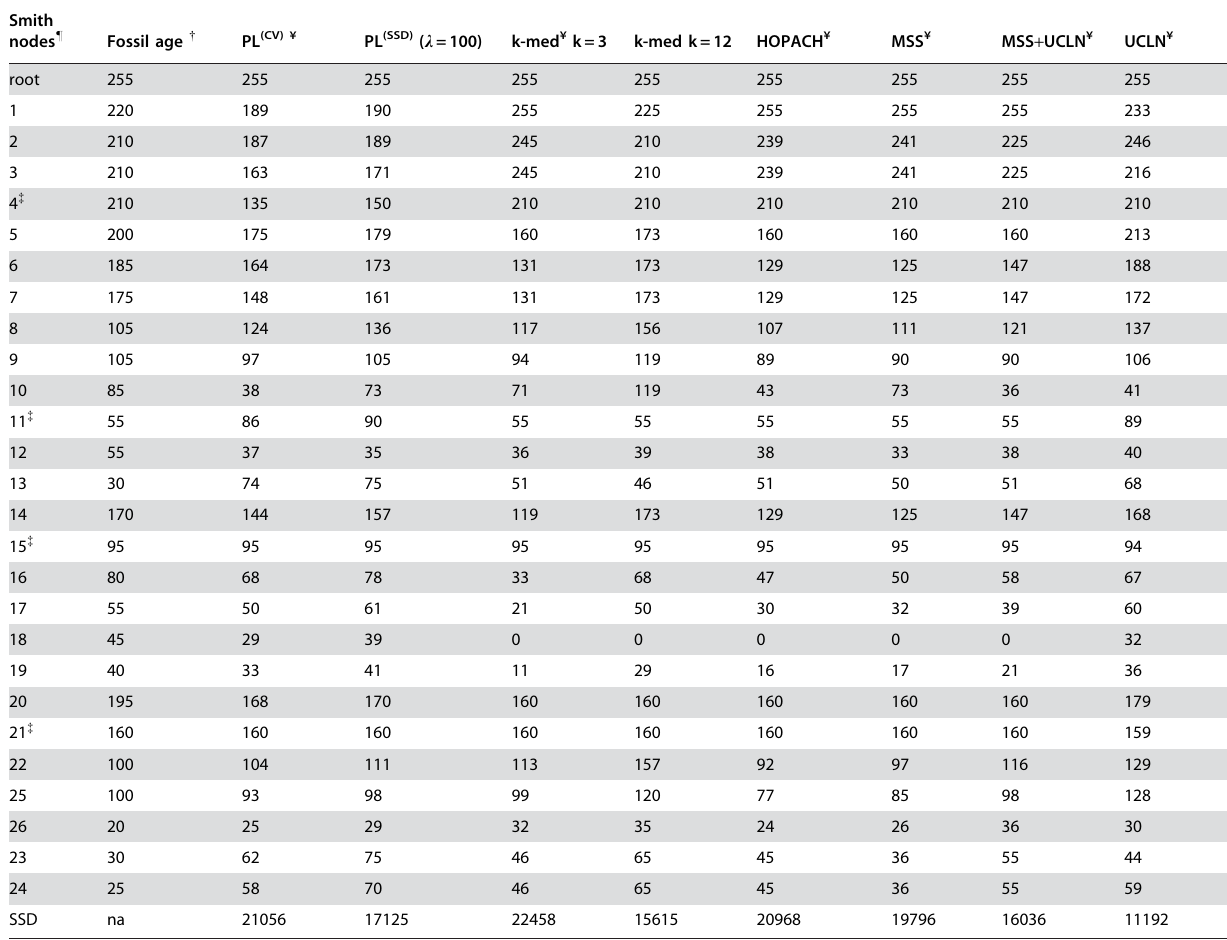
Table 2. Comparison of divergence times from fossils with those estimated from molecular data and four calibration points for